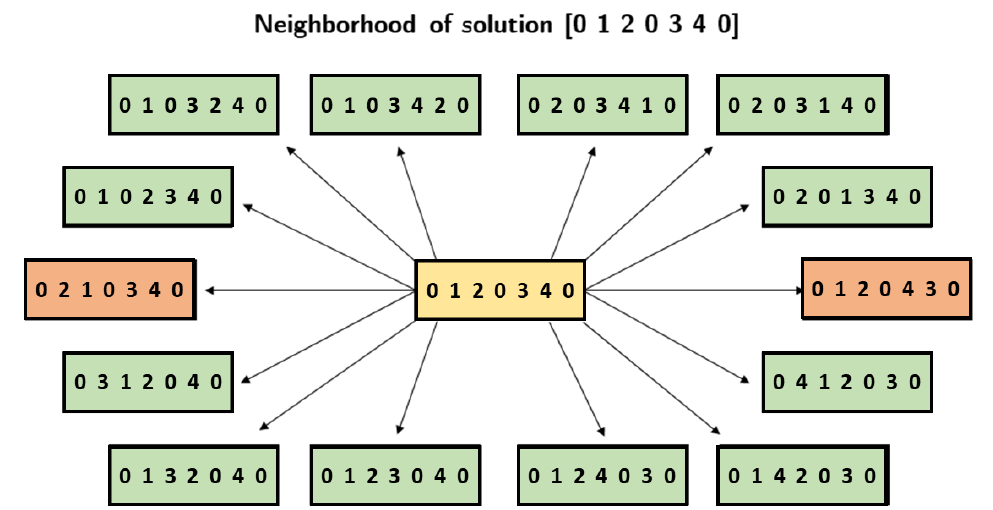
Figure 2. Example: Neighborhood of solution [0120340] (yellow): intra-route neighbors (orange) and inter-route neighbors